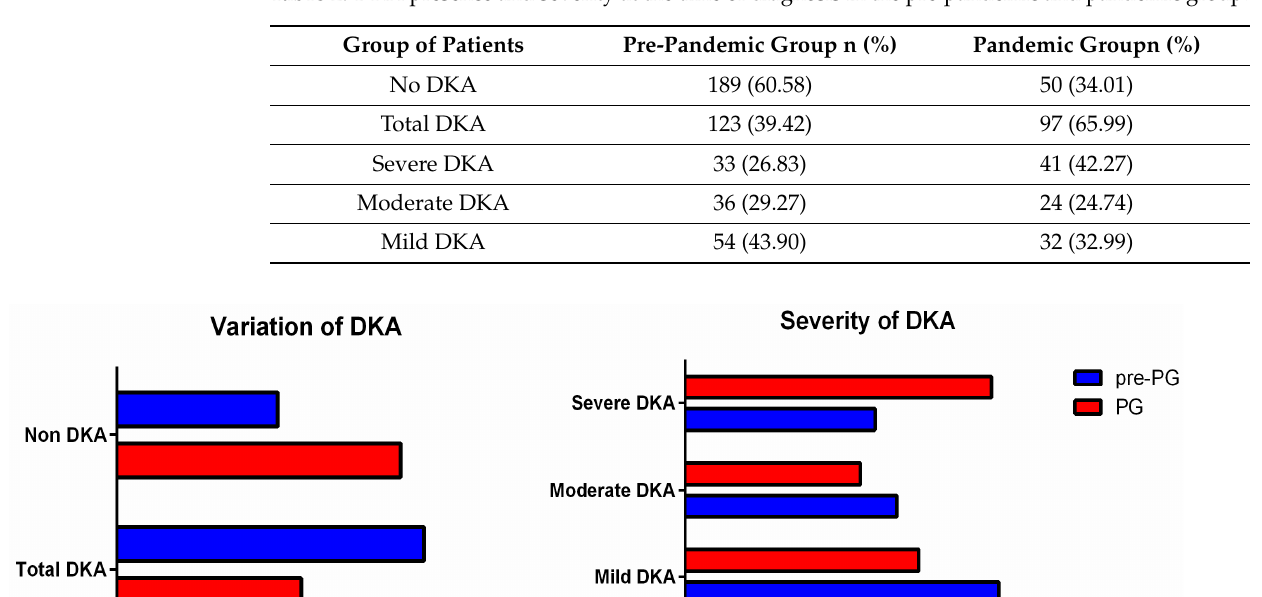
Table 2. DKA presence and severity at the time of diagnosis in the pre-pandemic and pandemic group.